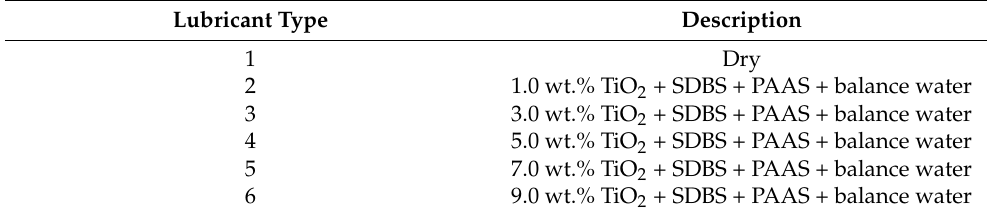
Table 1. Chemical compositions of lubricants.